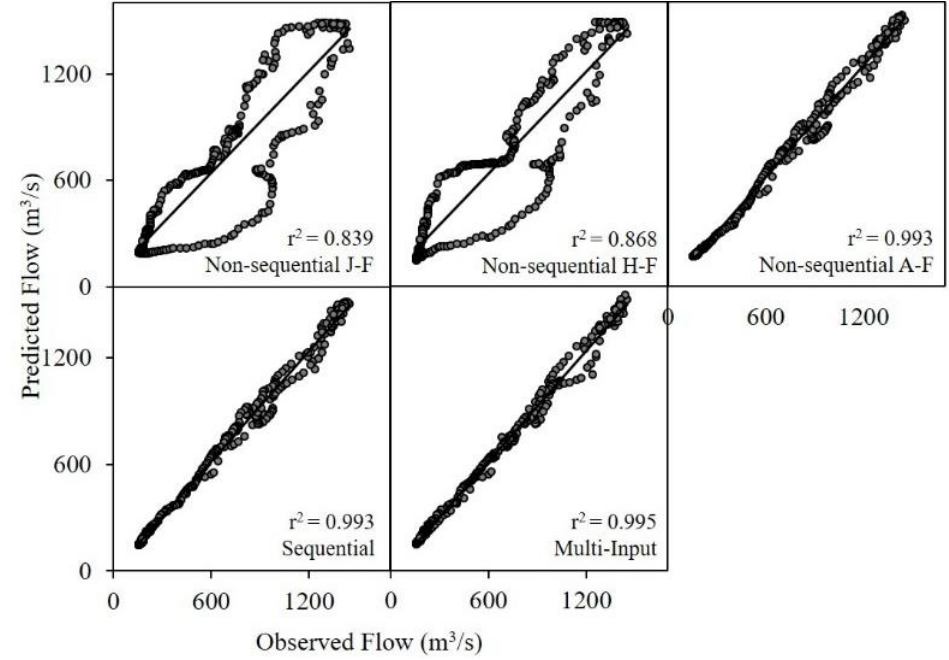
Figure 9. Scatter plots showing the correlation between the measured and predicted flow for the ANFIS models for Approach 2.